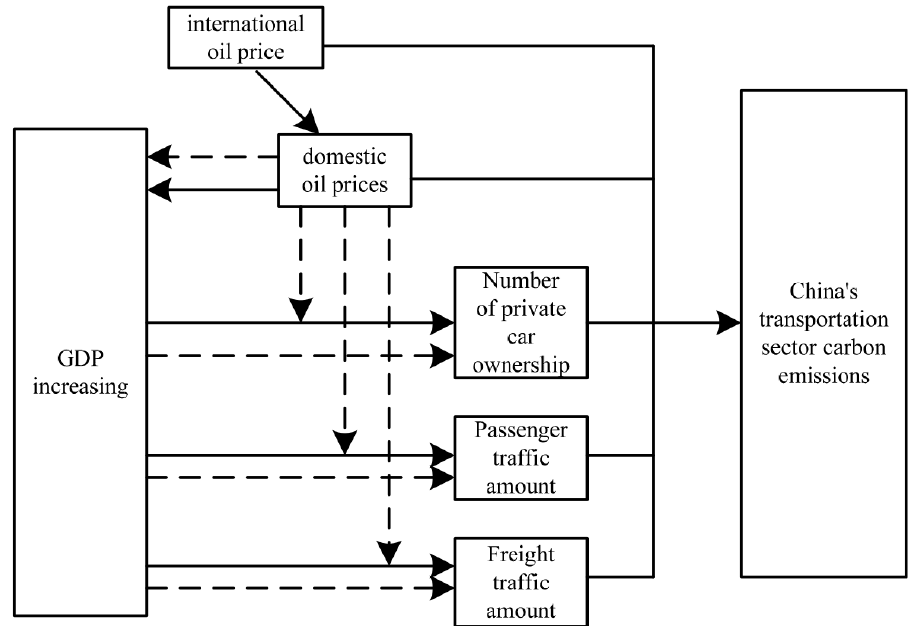
Figure 1. Influence Mechanism of Oil Price on Carbon